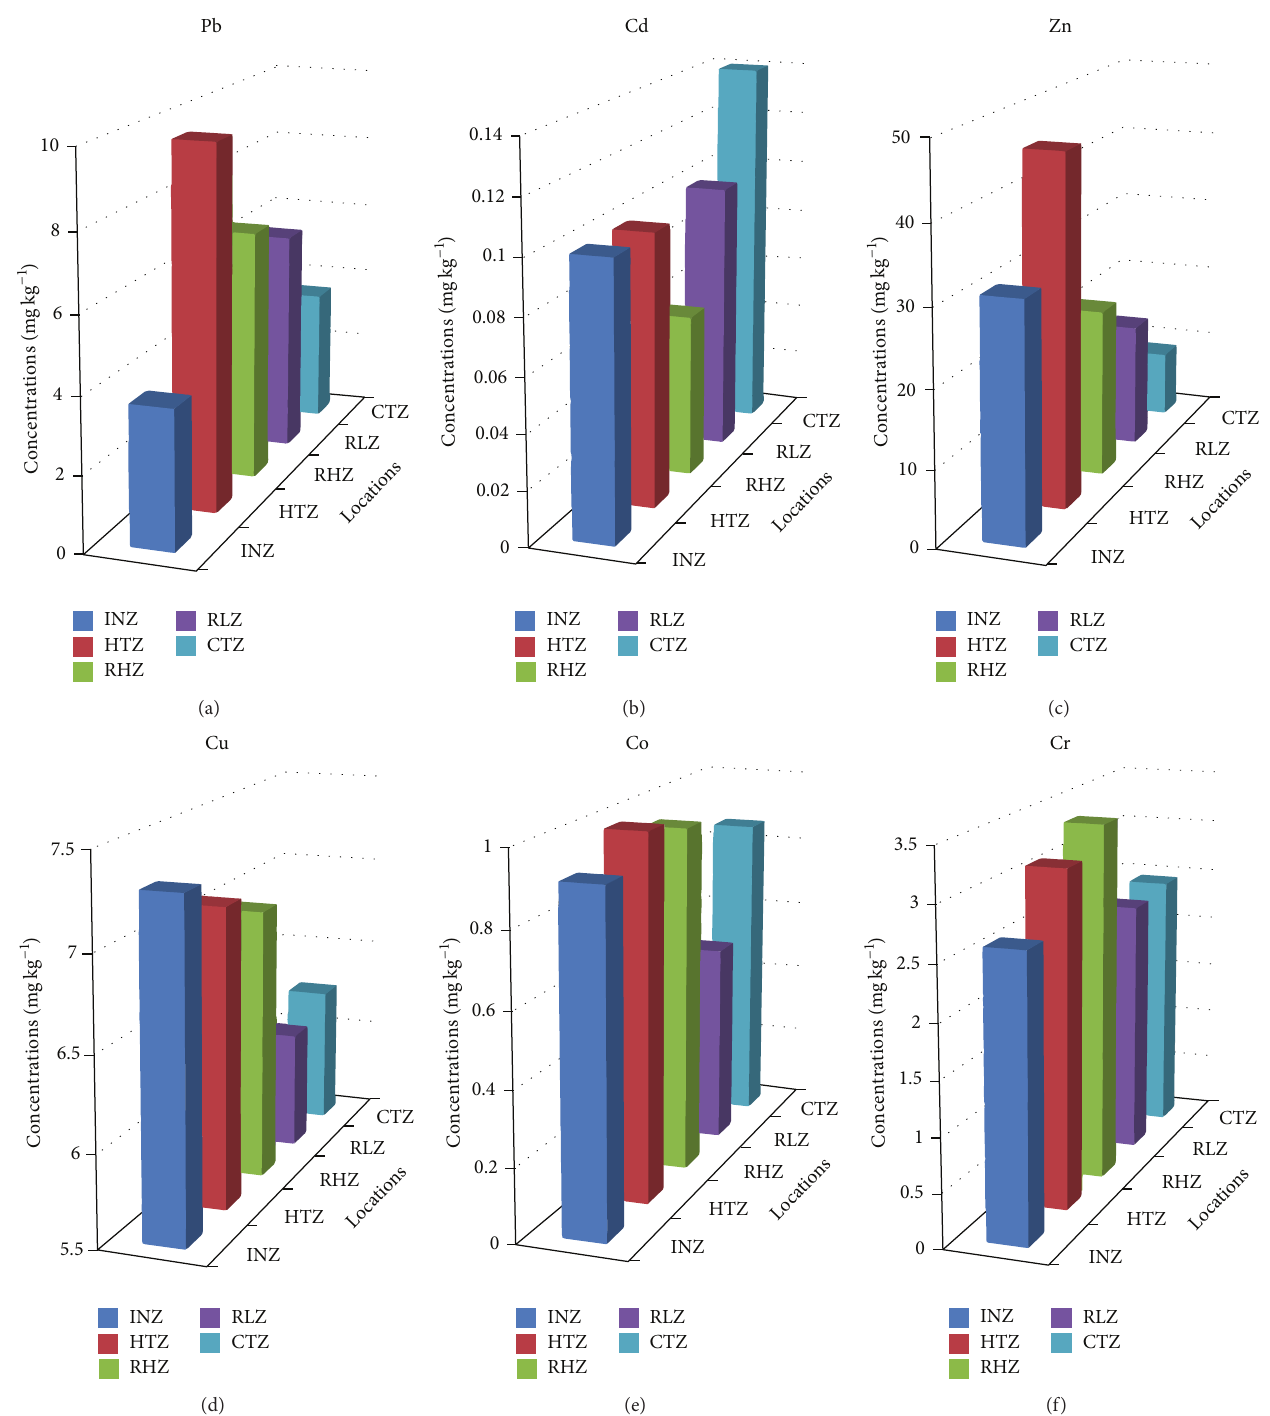
Figure 2: Metal concentrations in tree backs collected from all sampling zones. INZ: industrial zone; HTZ: high traffic commercial zone; RHZ: residential high traffic zone; RLZ: residential low traffic zone; CTZ: control